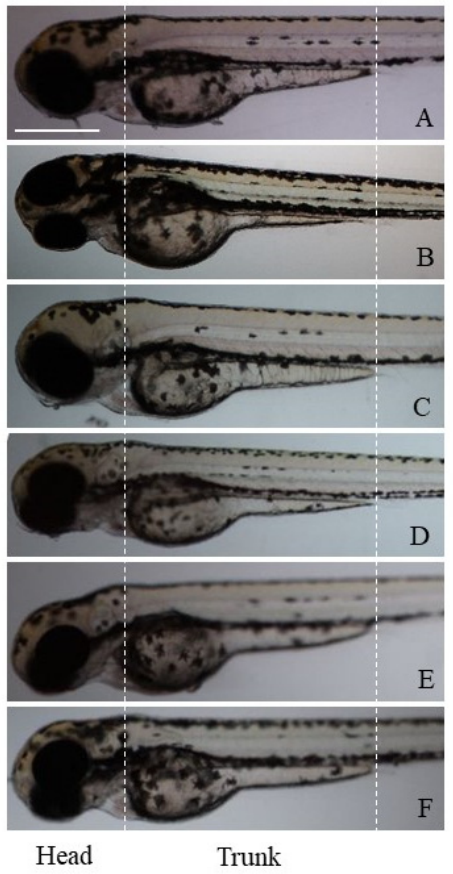
Figure 1. Image capture of larvae (5 dpf): ( A ) untreated control larvae; ( B ) static (B 0 , 0 Hz) exposure; ( C ) extremely low-frequency (ELF, 0.2 Hz) exposure; ( D ) low-frequency (LF, 270 kHz) exposure; ( E ) very-high-frequency (VHF, 100 MHz) exposure; ( F ) ultra-high-frequency (UHF, 900 MHz) expo- sure. Zebrafish specimens were exposed to different irradiations from <1–2 hpf to 5 dpf. Scale bar: 500 µm.